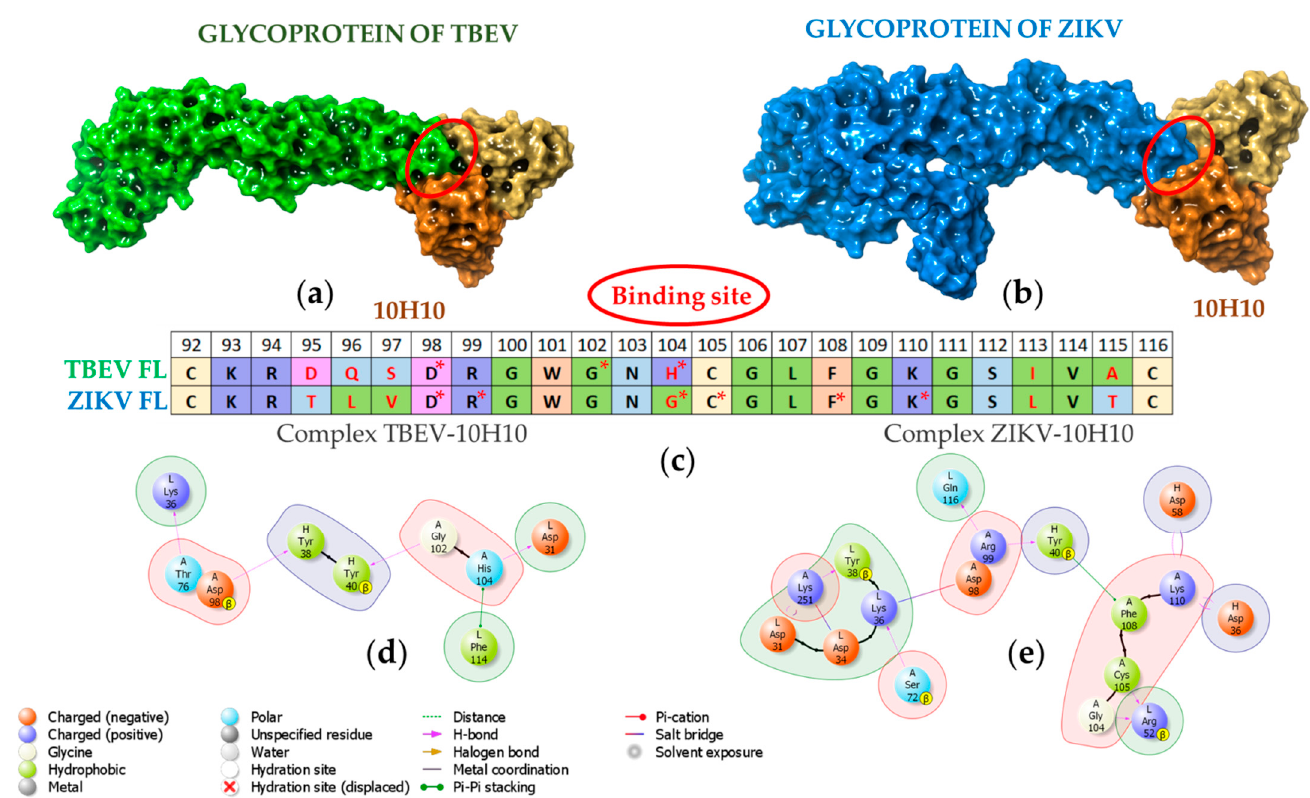
Figure 5. Visualization of flavivirus glycoproteins and 10H10 antibody protein–protein docking. ( a ) Docking position of the interaction of TBEV surface glycoprotein (E-protein) and 10H10 antibody (TBEV-10H10); ( b ) Docking position of the interaction between ZIKV E protein and 10H10 antibody (ZIKV-10H10); ( c ) Amino acids of the fusion loop included in the active binding site. Amino acids forming intramolecular interactions between VH/VL and FL are marked with asterisk; ( d , e ) The main intermolecular interactions between the amino acids of the FL and the antibody. Chain A is an amino acid sequence of the FL of TBEV and ZIKV; chains H and L correspond to VH and VL of 10H10 antibody.